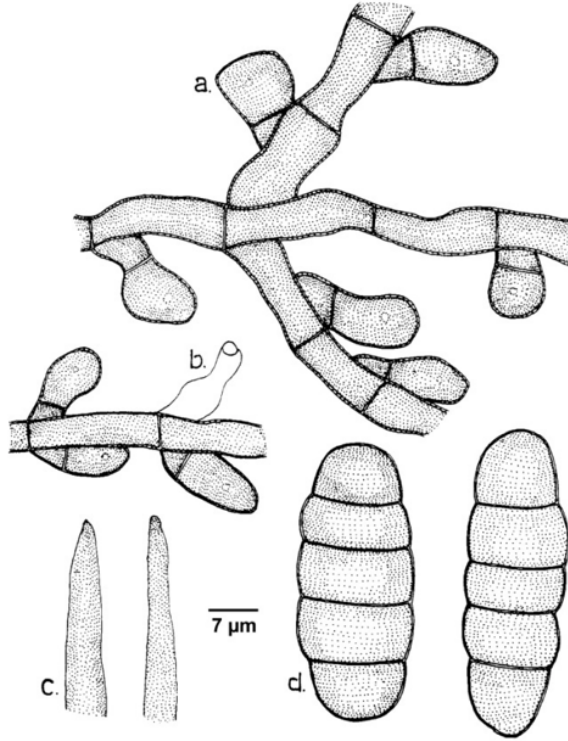
Figure 52. Meliola cadigensis var. toddaliae a - Appressorium; b - Phialide; c - Apical portion of mycelial